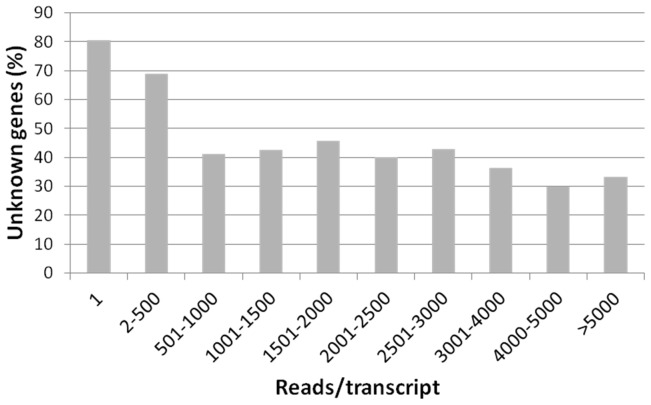
The percentage of unknown genes in Eutreptiella transcripts.The transcripts were assigned into different categories based on the number of reads in each transcript. In general, transcripts represented by high numbers of reads have less proportions of unknown genes.